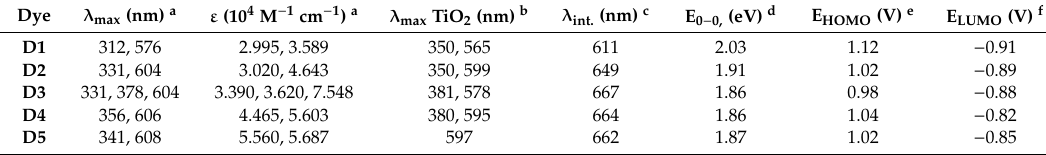
Table 1. Photophysical and electrochemical properties of the dyes D1 – D5 .